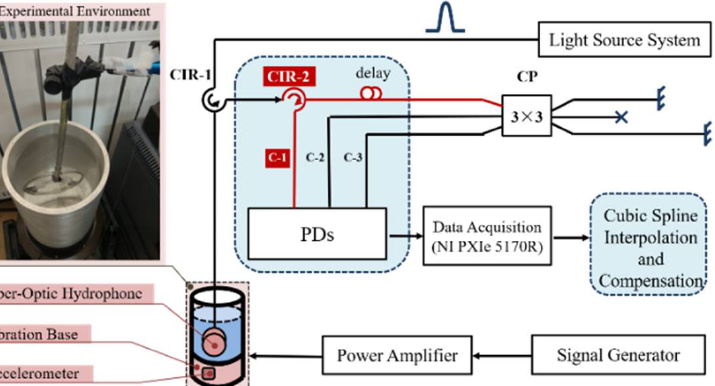
Figure 3. Experimental principle of the path-match interferometric fiber-optic hydrophone system.